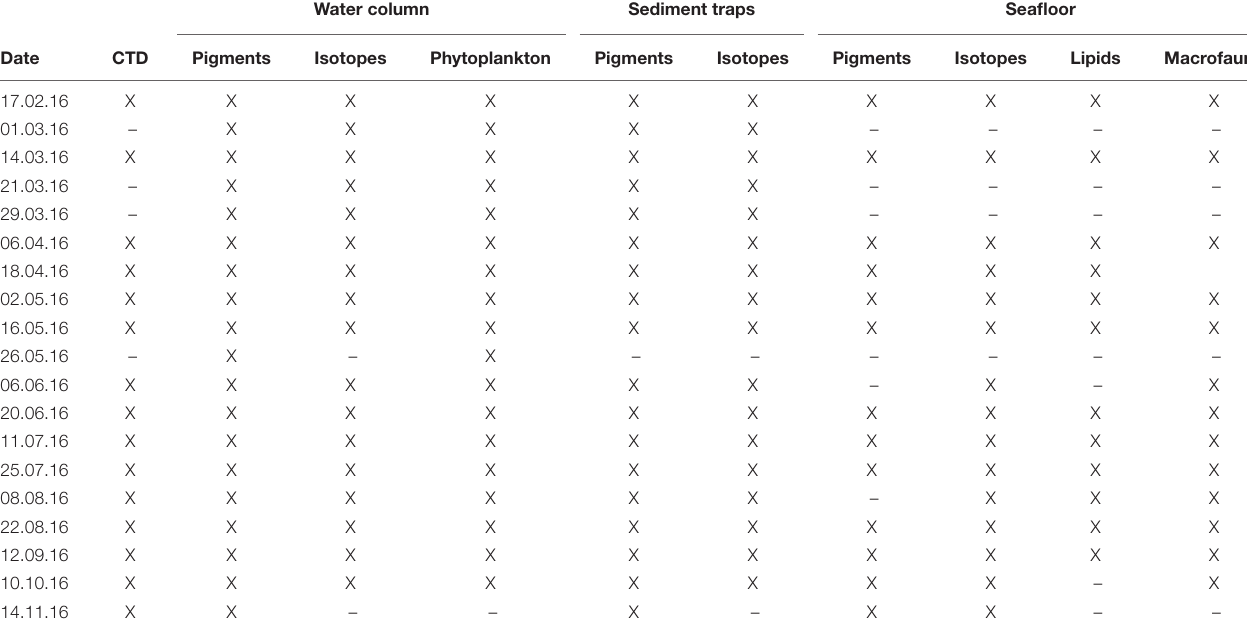
TABLE 1 | Summary of the samples collected across the water column, the sinking particulate matter, and the seafloor compartments on the different sampling dates